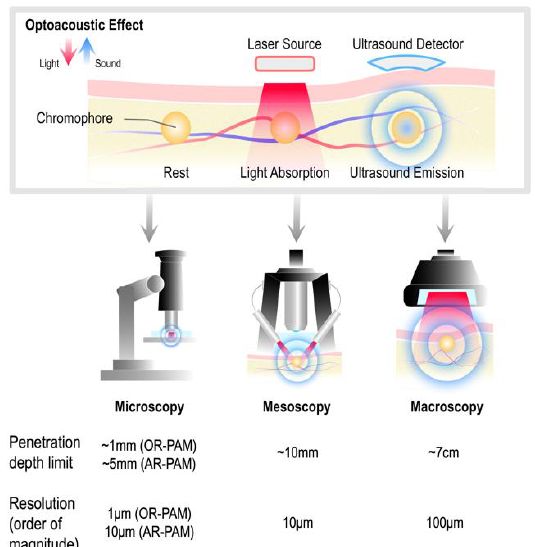
Figure 1. Optoacoustic principle and imaging configurations. Above , the optoacoustic effect, in which light absorbed by chromophores in tissue results in emission of ultrasound. Below , categorization of optoacoustic imaging configurations into microscopic, mesoscopic, and macroscopic, with the corresponding tissue penetration depth limits and resolution orders of magnitude, as reported in relevant reviews [8,9,23].